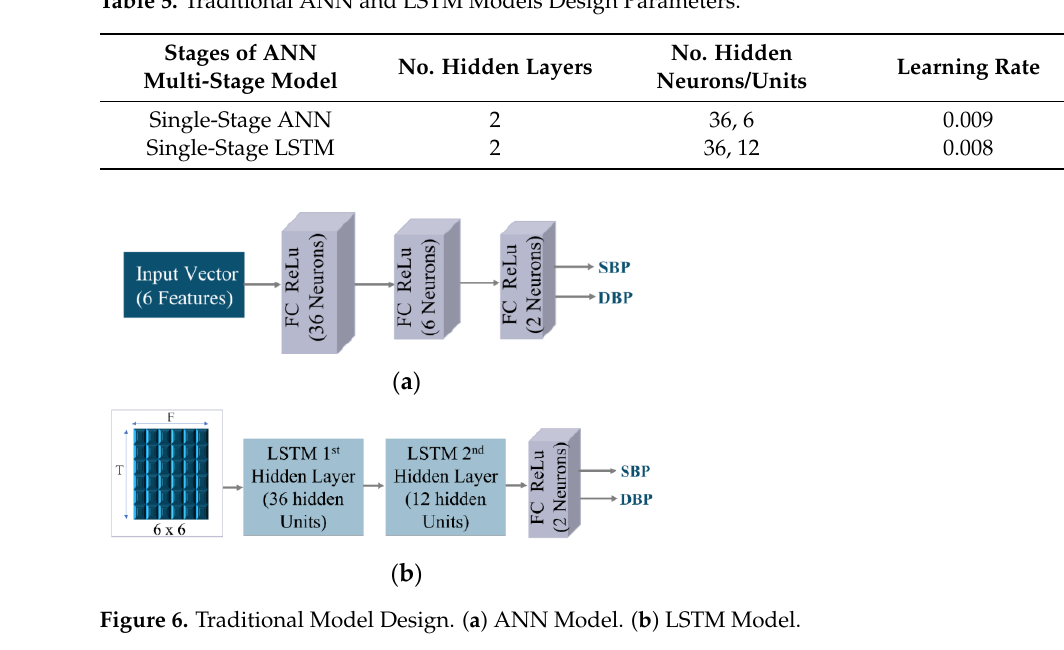
Table 5. Traditional ANN and LSTM Models Design Parameters.